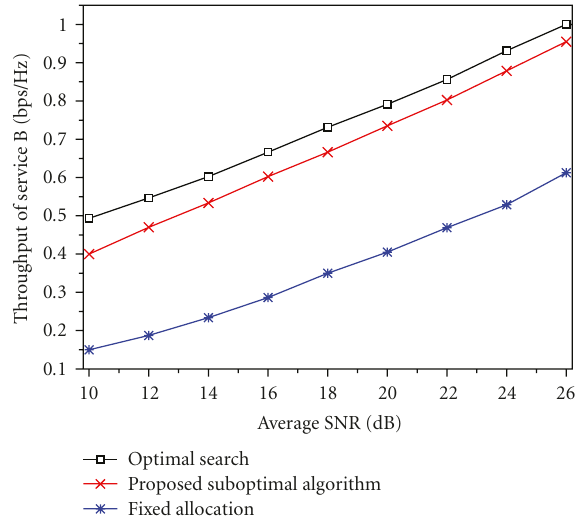
Figure 4: Throughput of service B (service A’ required rate R =